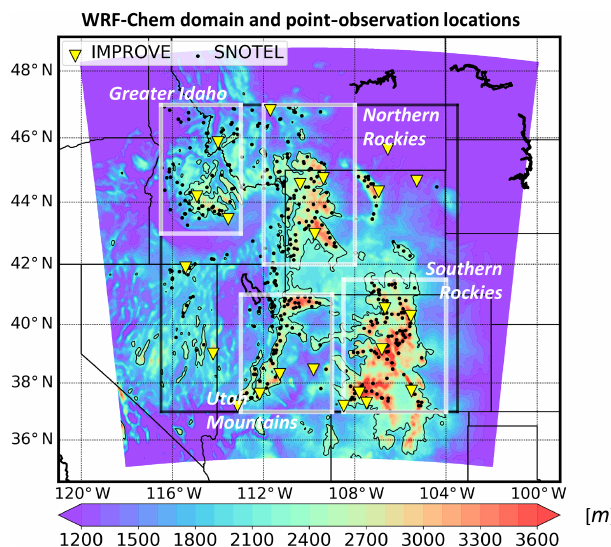
Figure 1. WRF-Chem domain with analysis subregions (white transparent boxes). The color fill represents the surface elevation (m), and the thin black line denotes the low-pass-filtered 2200m isopleth. The thick black line bounds our analysis region. Black circles represent the 418 analysis snow telemetry (SNOTEL) sites, while the yellow inverted triangles represent the 23 analysis IM- PROVE